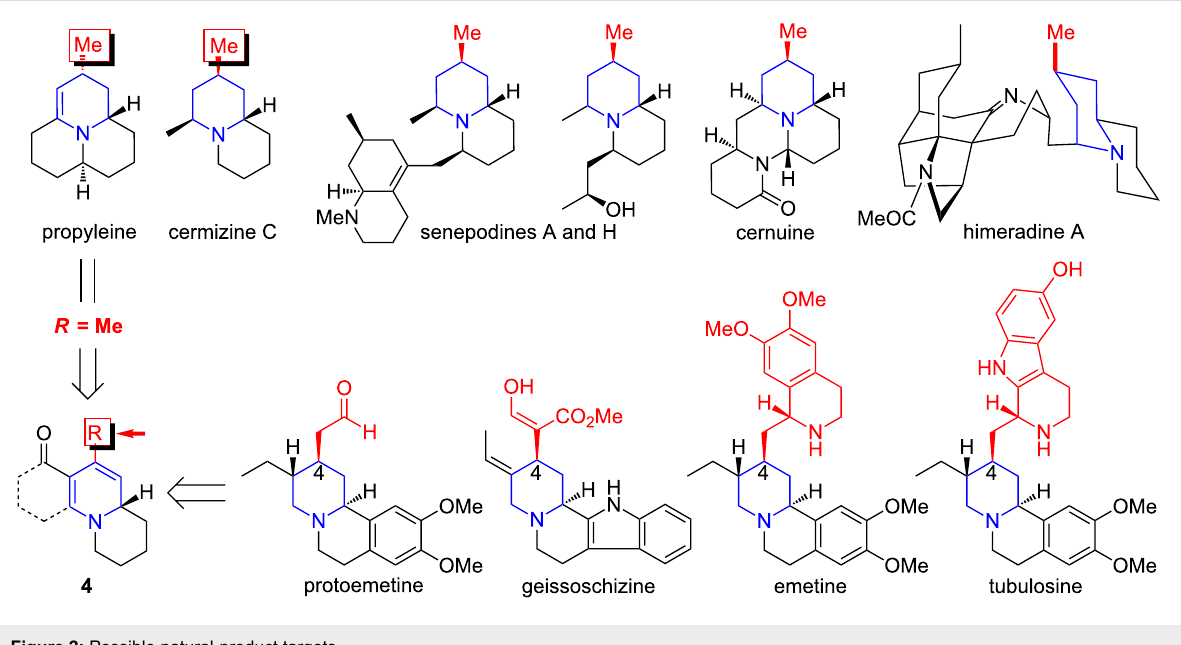
Figure 2: Possible natural-product targets.